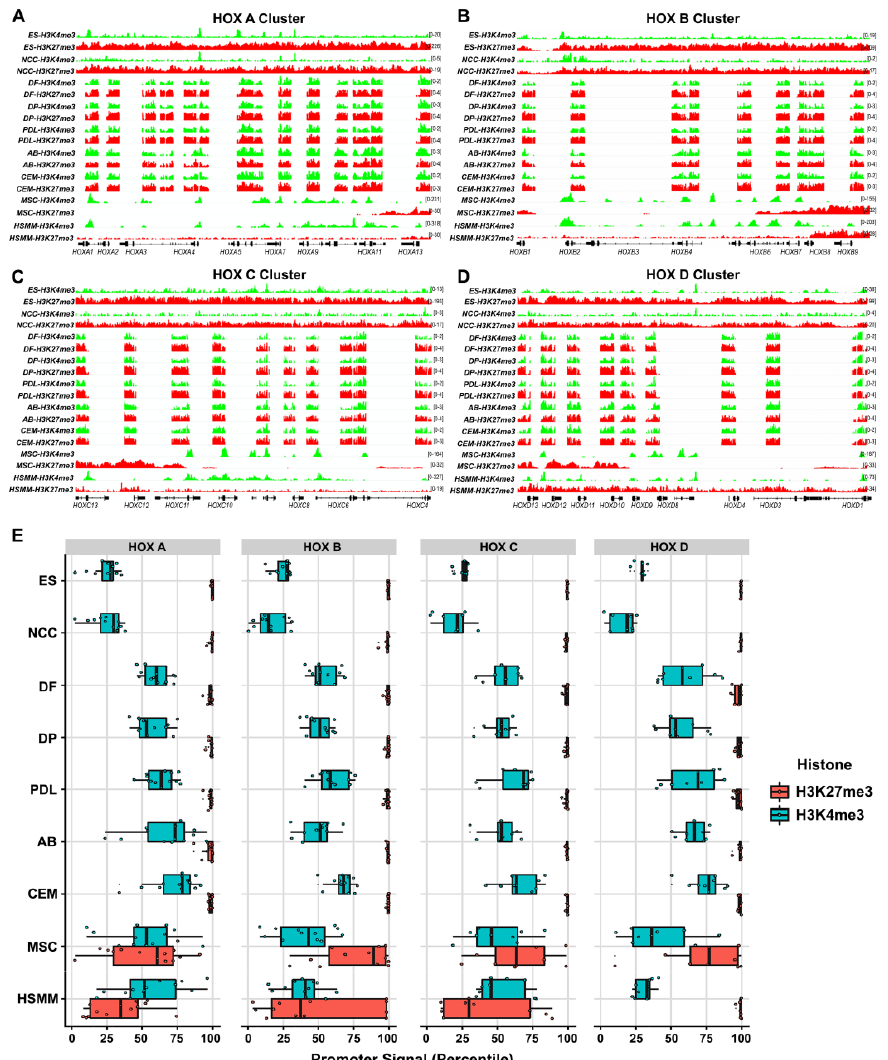
Figure 1. Histone modification profiling at HOX promoters in human progenitor cells. ( A – D ) IGV genome browser snapshot of H3K4me3 (green track) and H3K27me3 (red track) enrichment for all HOX genes from HOXA ( A ), HOXB ( B ), HOXC ( C ), and HOXD ( D ) clusters in embryonic stem cells (ES), neural crest cells (CNCC), dental follicle (DF), dental pulp (DP), periodontal ligament (PDL),